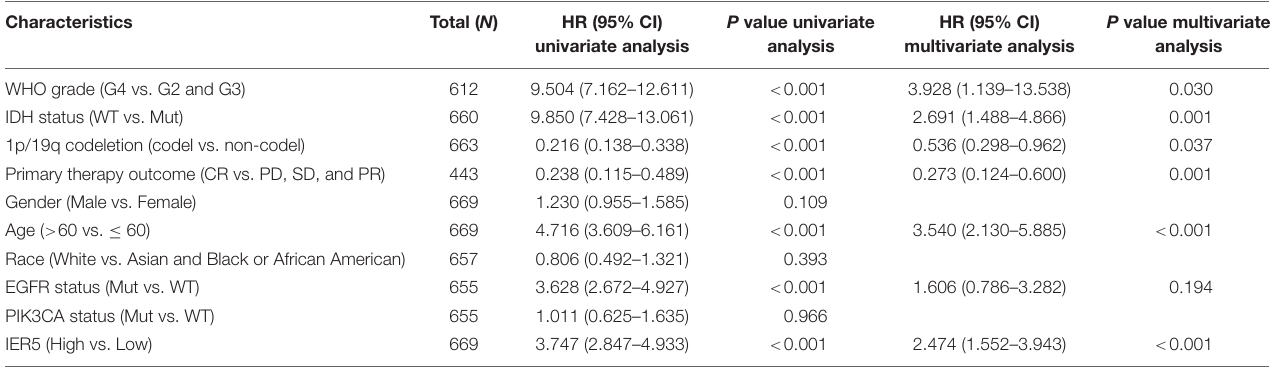
TABLE 3 | (A) Association with overall survival and clinicopathologic characteristics in glioma patients using Cox regression. (B) Multivariate survival model after variable selection. Characteristics